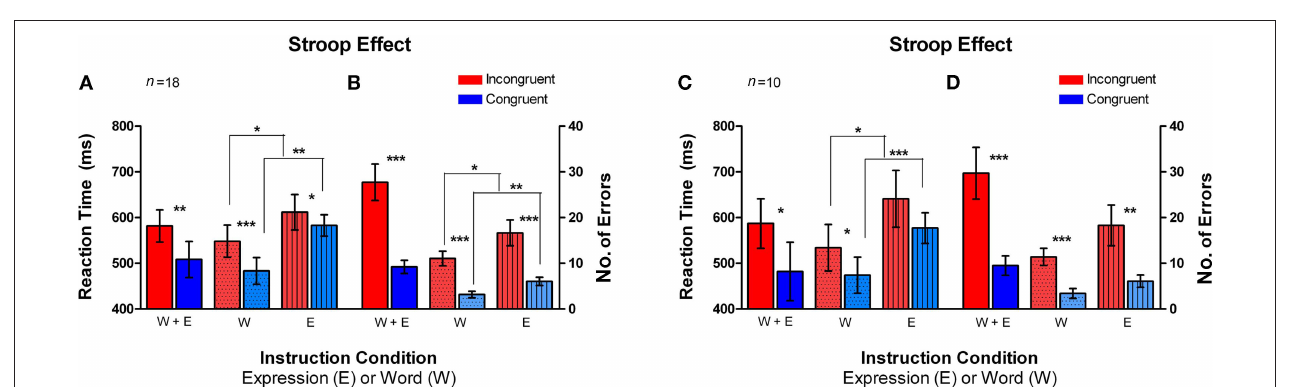
(B) There was also a larger average number of errors made on the expression instruction condition as compared to the word instruction condition ( n = 18, fMRI and Behavioral subjects). (C,D) Same pattern was observed in RT and number of errors for fMRI subjects only ( n = 10). **signifies p < 0.005, ***signifies p < 0.0005.